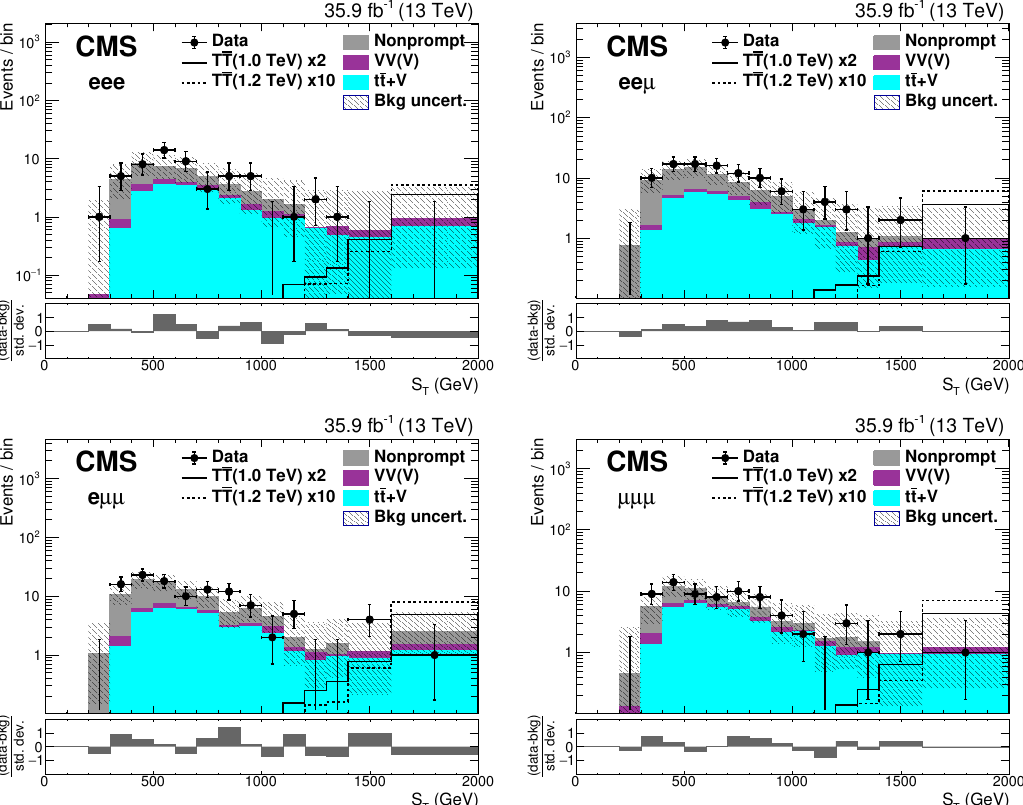
Figure 7 . Distributions of S T in the trilepton (cid:12)nal state before the (cid:12)t to data, in the four (cid:13)avor categories. The black points are the data (horizontal bars indicate the bin width) and the (cid:12)lled histograms show the background distributions, with simulated backgrounds grouped into categories as described in section 3. The expected signal is shown by solid and dotted lines for T quark masses of 1.0 and 1.2 TeV. The (cid:12)nal bin includes over(cid:13)ow events. Uncertainties, indicated by the hatched area, include both statistical and systematic components. The lower panel shows the di(cid:11)erence between data and background divided by the total